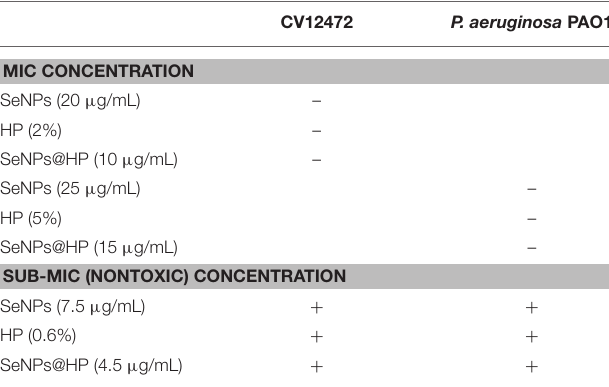
TABLE 1 | Minimum inhibitory concentration (MIC) and sub-MIC of samples against CV12472 and P. aeruginosa PAO1.